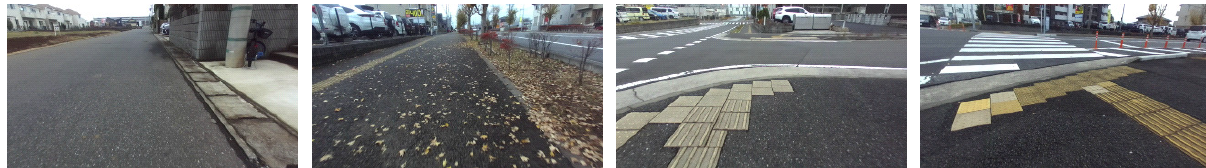
Figure 7. Representative snapshots of driving environments in